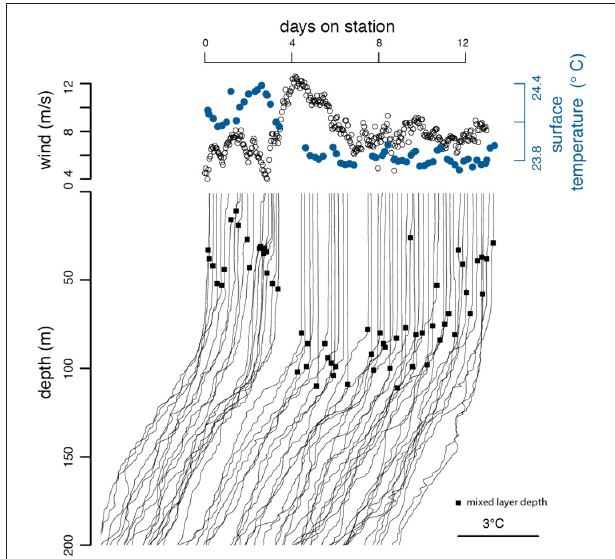
FIGURE 3 | Wind speeds and depth/temperature profiles at Station ALOHA during a 2-week sampling period (KM1409) in March 2014. The depth profiles are shifted according to the time of measurement. The black circles on the temperature curves of the bottom panel indicate mixed-layer depth.